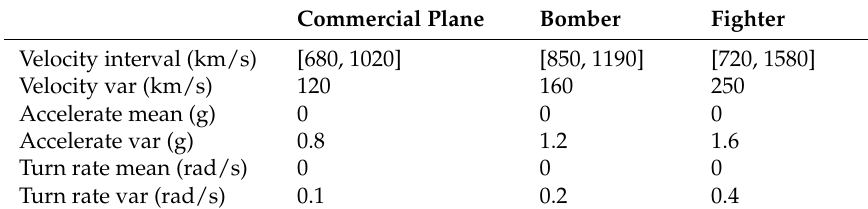
Table 1. Numerical values for priori pignistic class probability density.